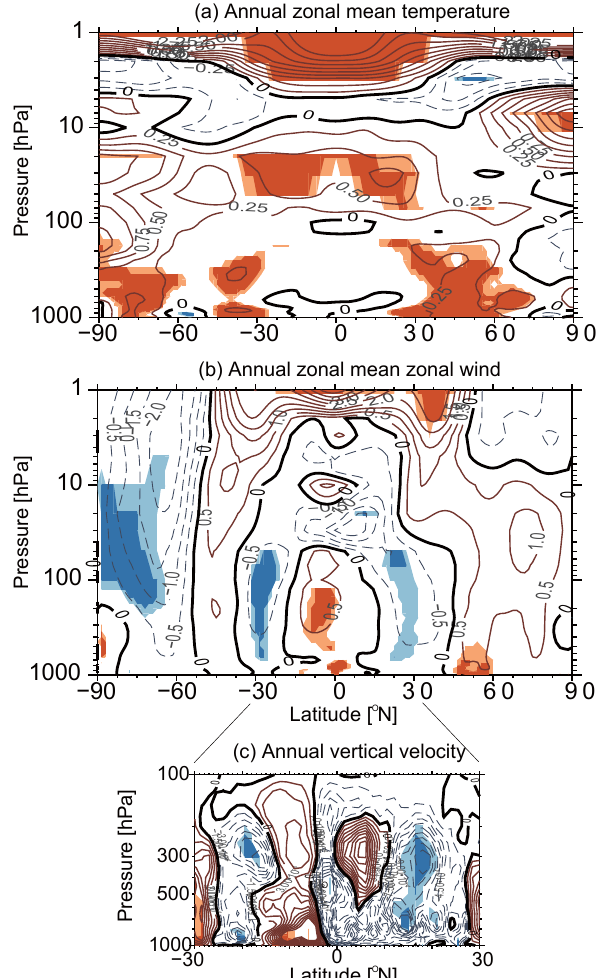
Figure 5. Solar regression coefficients of the annual zonal mean (a) air temperature, (b) zonal wind and (c) vertical velocity in the tropical troposphere. Solid (dashed) contours indicate positive (neg- ative) values and are drawn every (a) 0.25K, (b) 0.5ms − 1 and (c) 5mday − 1 . Areas of 90 and 95% statistical significance are shown by light and dark shading, respectively, in red (positive) and blue